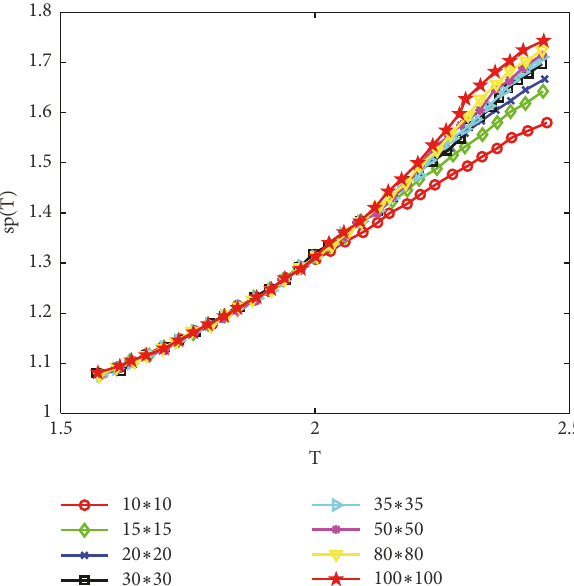
Figure 2: Functional images of magnetic susceptibility 𝜒 𝑁 (𝑇) and temperature 𝑇 .